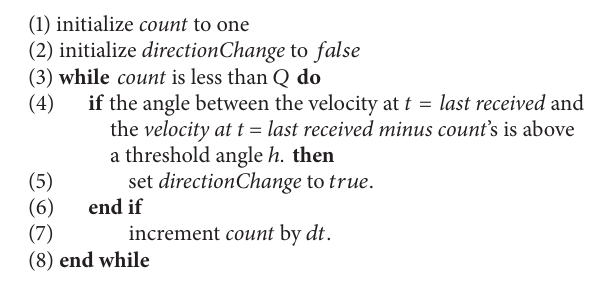
Algorithm 4: Check player direction change.